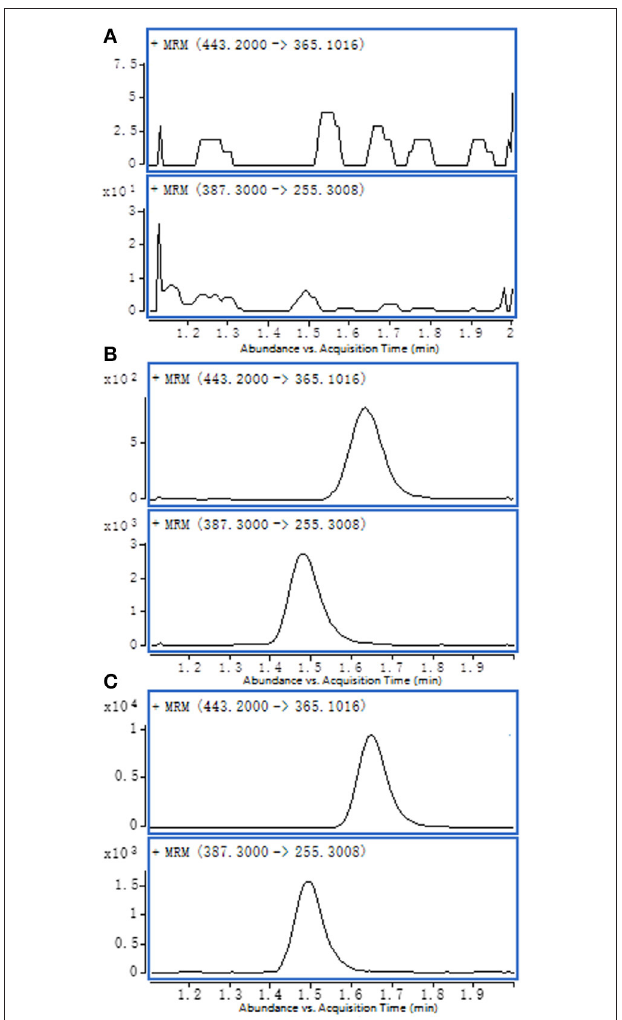
Supplementary Table 2 . All intra-day and inter-day precision and accuracy were acceptable with RSD% < 15% and RE% within ±